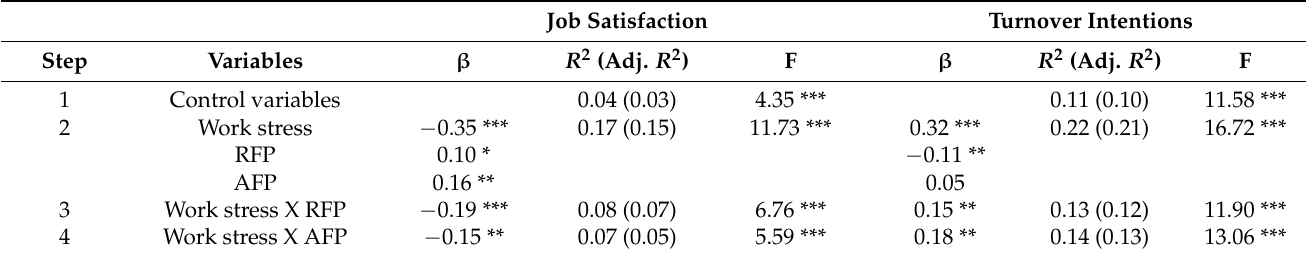
Table 3. Regression results for testing moderation effect of reciprocal filial piety (RFP) and authoritarian filial piety (AFP) on the relationship between work stress and job satisfaction, and between work stress and turnover intention.